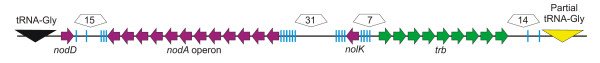
Schematic representation of the symbiosis region. Genes described in the text are indicated by arrows; the others are not individually represented, but their number is specified in the pentagons. The symbiotic region is flanked by tRNA-Gly (triangles) and interspersed by multiple transposases and integrases (blue lines). Genes in the nodA operon are nodABCSUIJZnoeCHOP and genes in the trb operon are trbBCDEJLFGI.